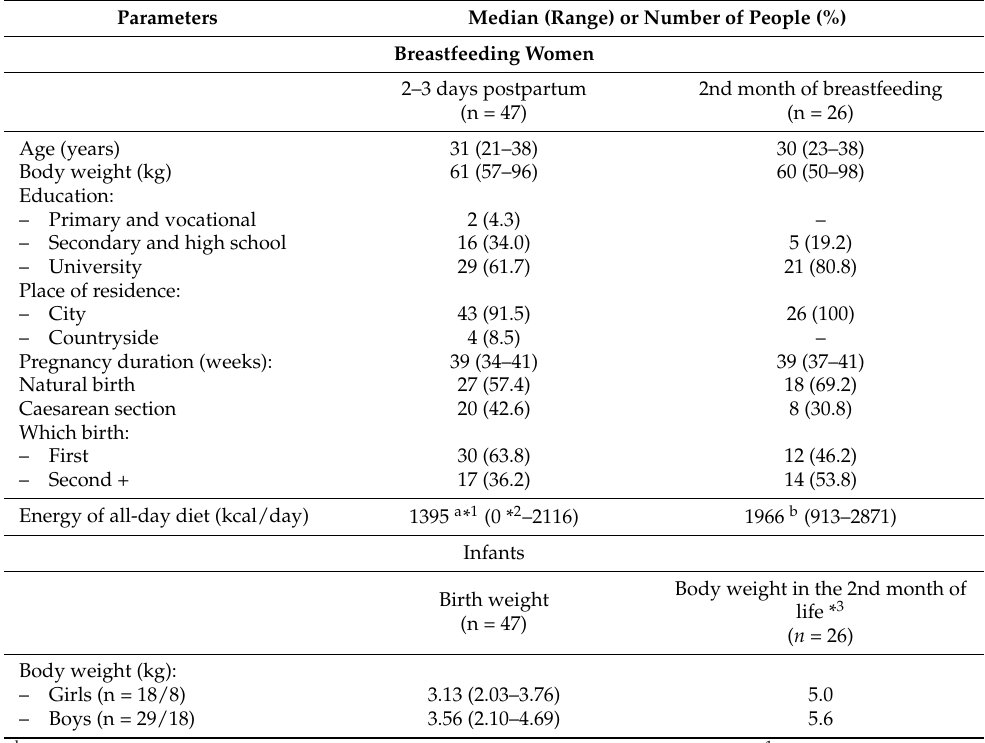
Table 1. Characteristics of breastfeeding women and their